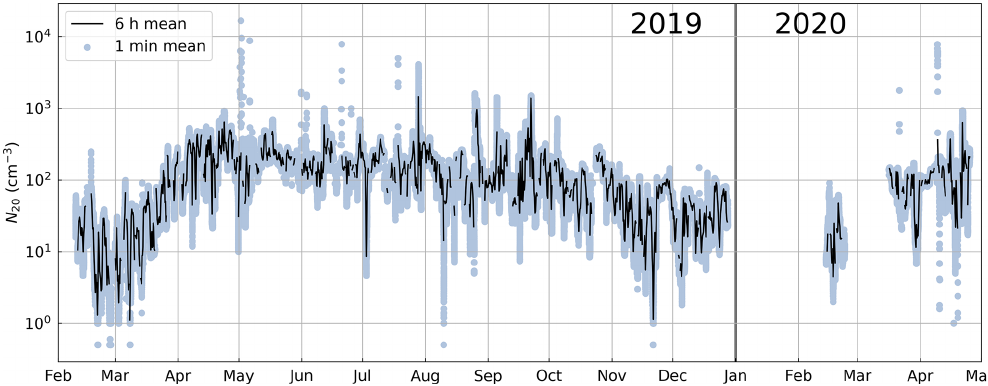
Figure 4. Surface N 20 from the CPC at Summit from February 2019 until May